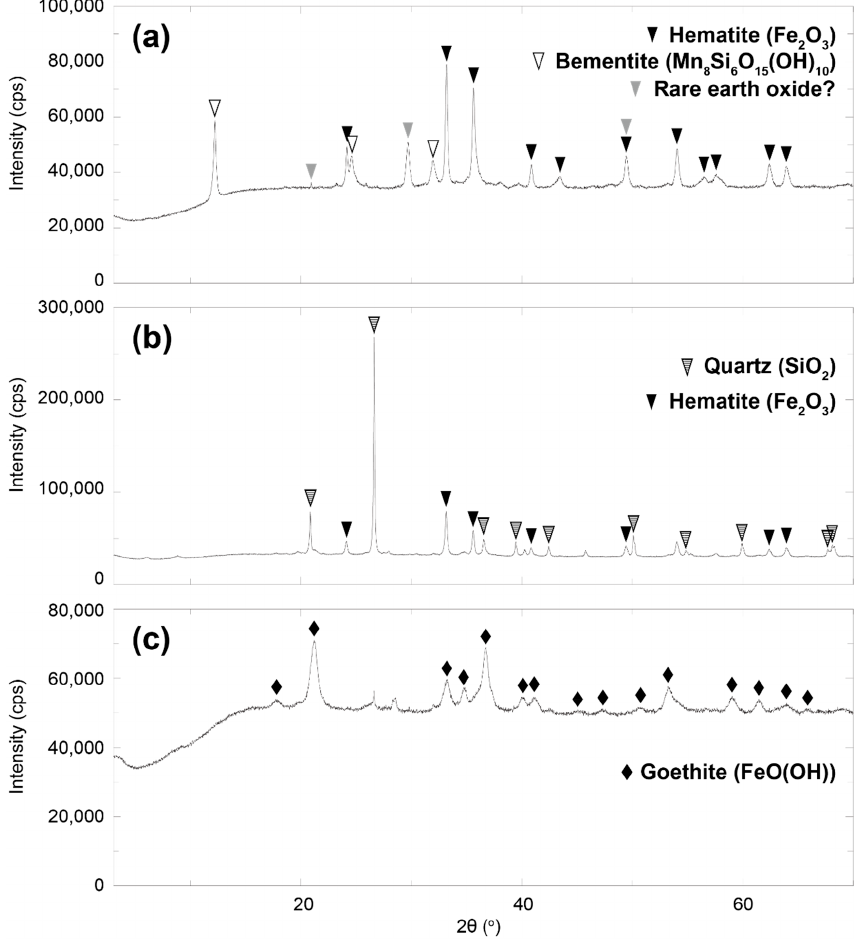
Figure 1. X-ray diffractograms of umber samples. ( a ) Kunimiyama umber, ( b ) Aki umber, and ( c ) Figure 1. X-ray di ff ractograms of umber samples. ( a ) Kunimiyama umber, ( b ) Aki umber, and Cyprus umber. ( c ) Cyprus